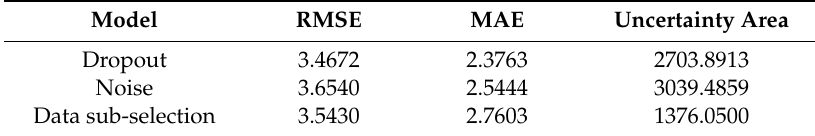
Table 6. Comparison of uncertainty estimation